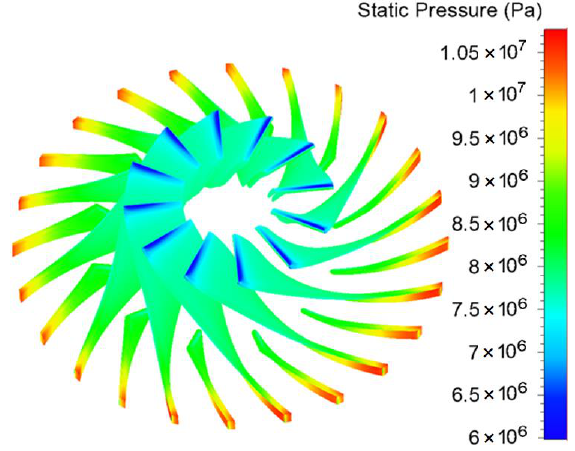
Figure 11. The pressure distribution on the surface of impeller blades.